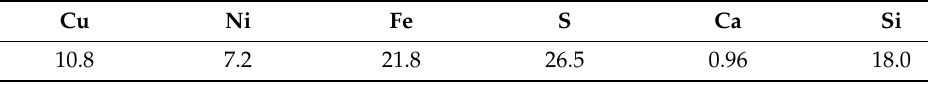
Table 1. Main element content (wt%) in concentrate.